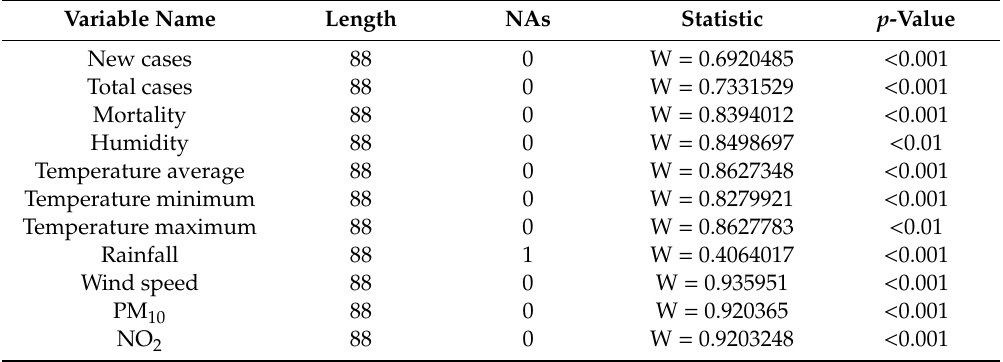
Table A1. Shapiro-Wilk normality test application. All p-values are less than 0.001 and 0.01 significance level respectively, thus the null hypothesis is rejected that the variables have a normal